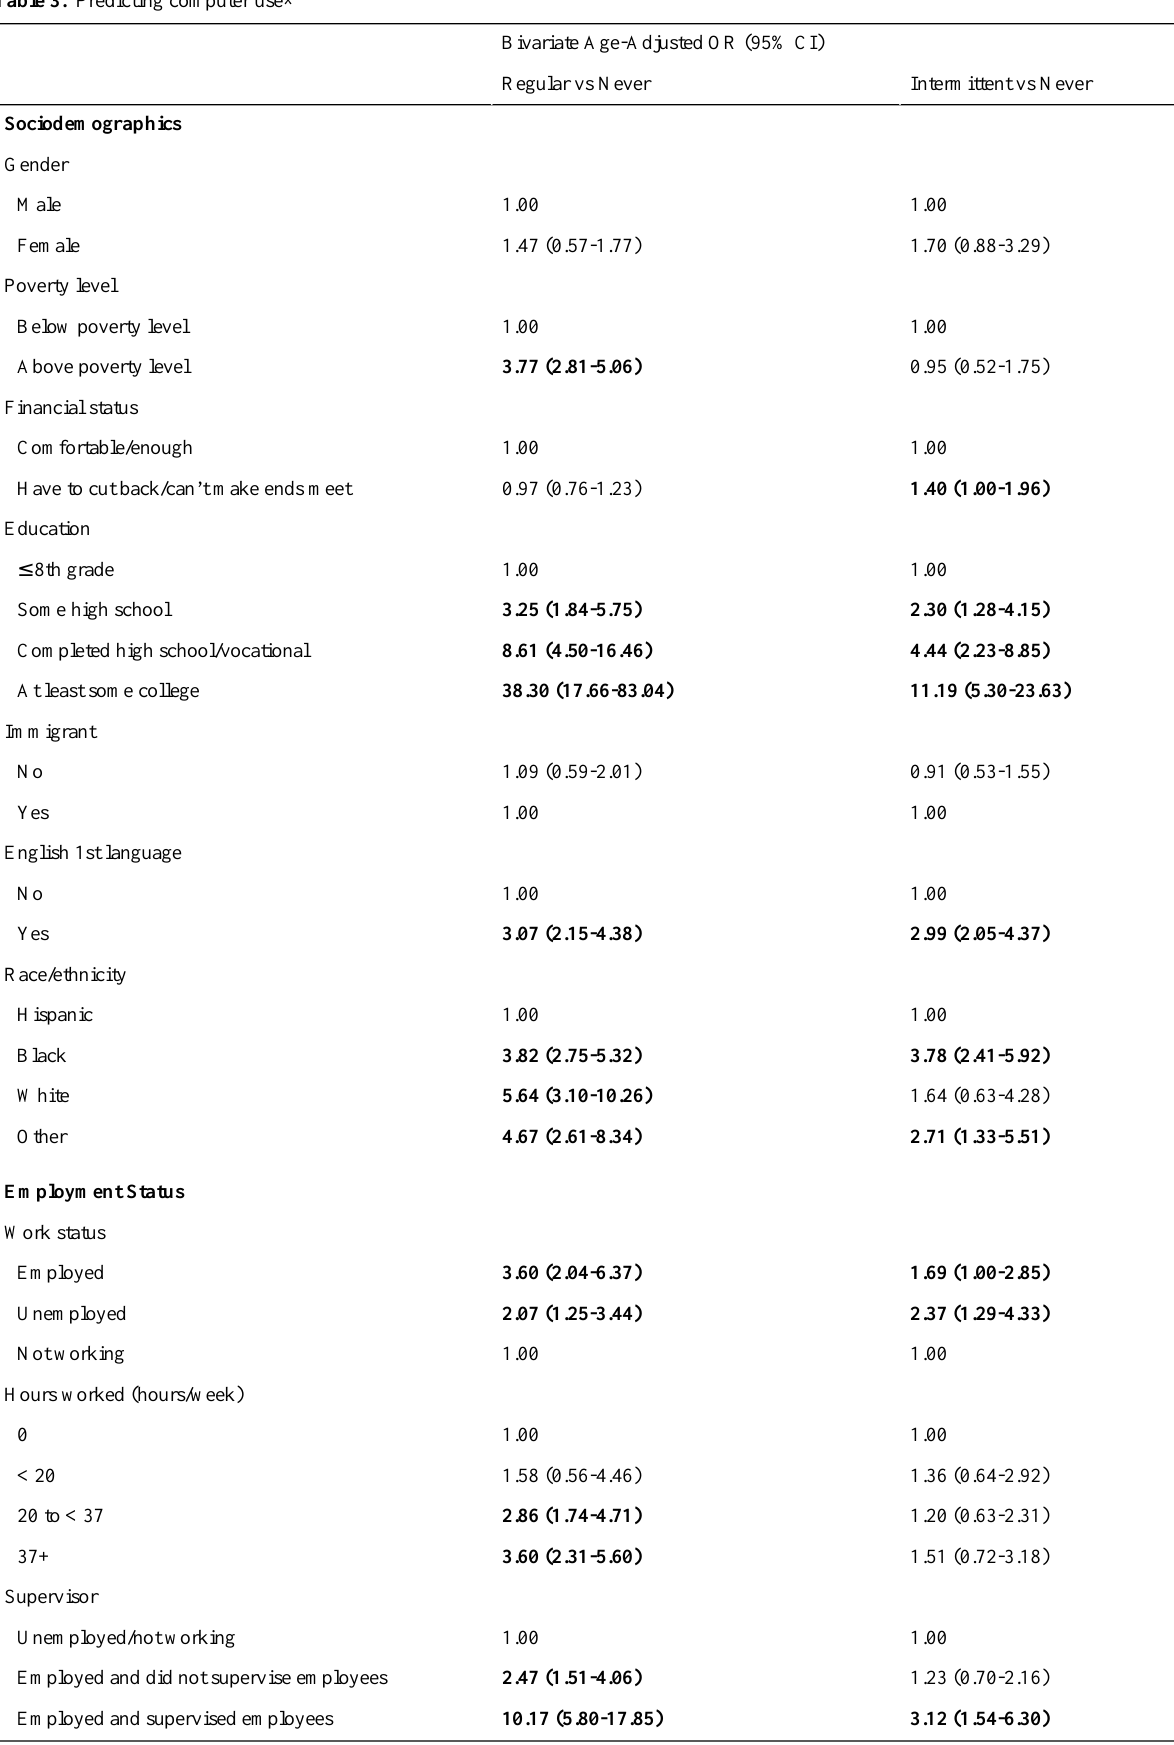
Table 3. Predicting computer use*